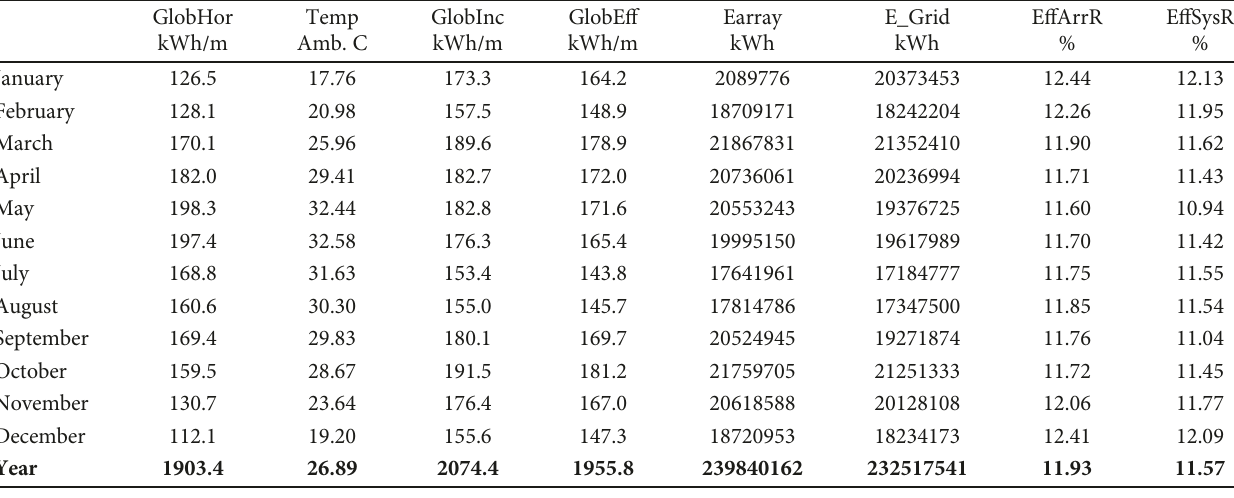
Table 8: New simulation variant balance and main results.